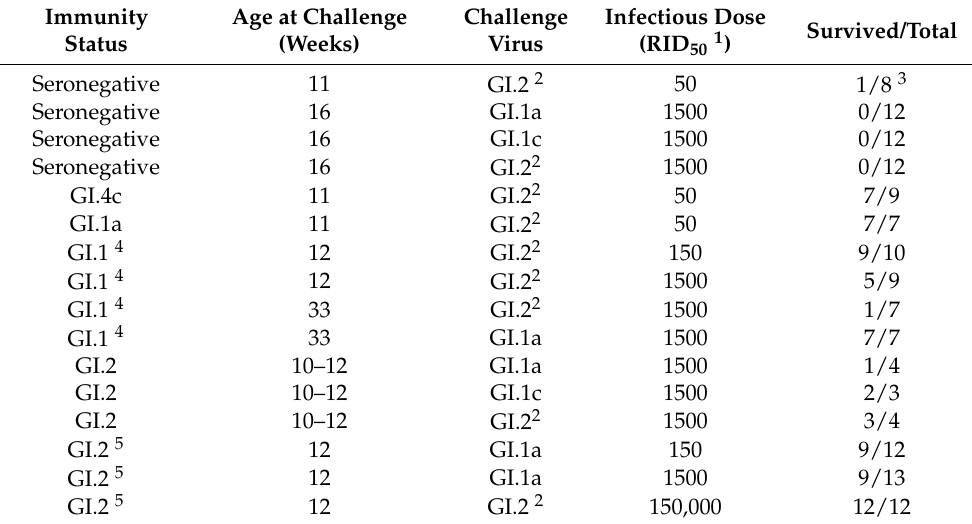
Table 1. Immunity status, age at challenge, challenge virus, infectious dose and the subsequent survival proportion of rabbits with experimentally or naturally acquired immunity. Immunity Age at Challenge Status (Weeks)